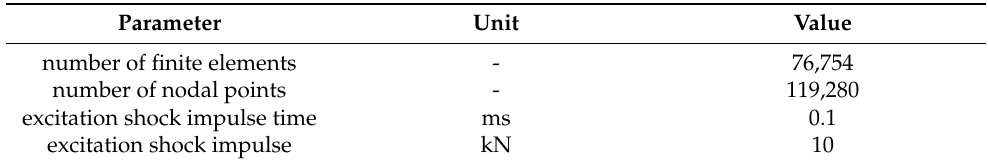
Table 2. FEM numerical simulation